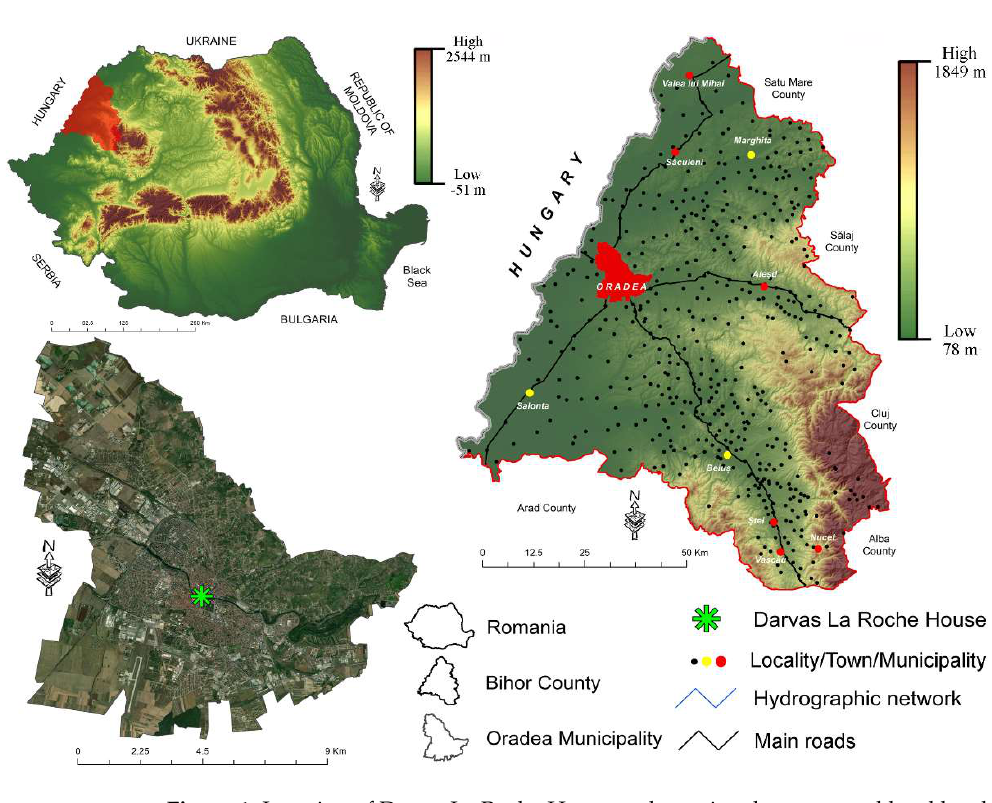
Figure 1. Location of DarvasLa Roche House at the national, county and local level.